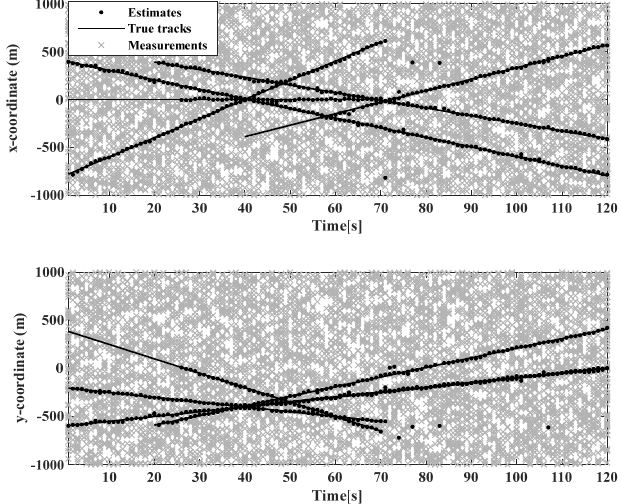
Figure 7. Real trajectories, measurements, and estimates in Cartesian coordinates in linear models.